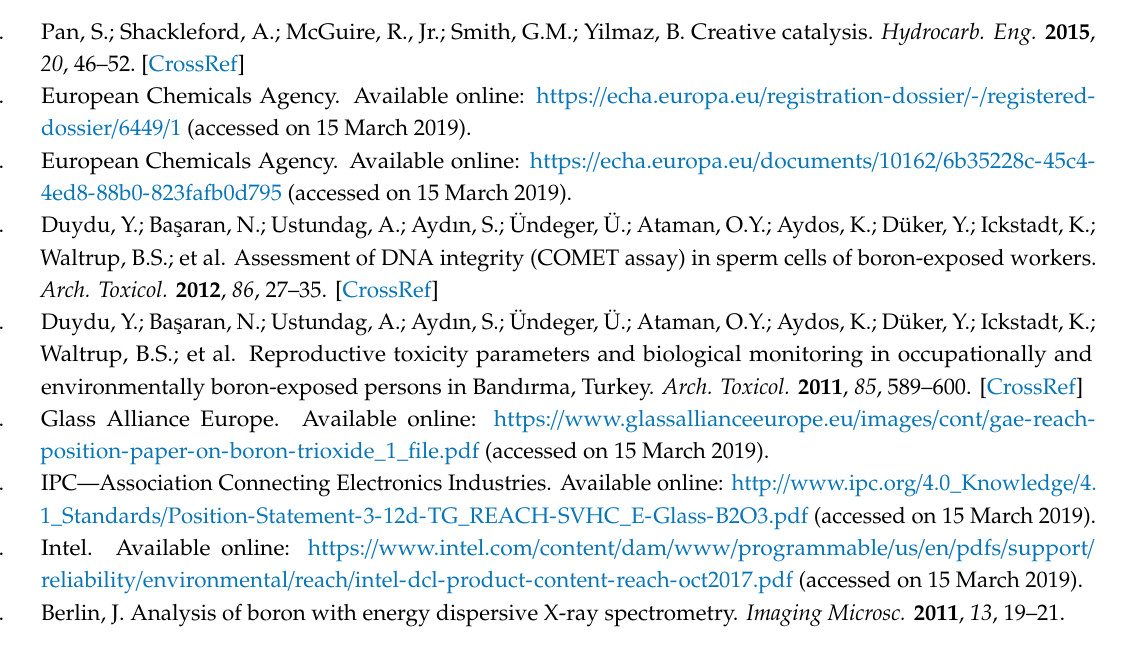
Figure S1: XPS P 2s and B 1s spectra for FCC ZSM-5 additive samples without boron (top) vs. with 1 wt.% B 2 O 3 (bottom). B 1s region is overlapping with P 2s region, Figure S2: 11 B NMR spectrum of ZSM-5 additive with 1 wt.% B 2 O 3 , Figure S3: 11 B NMR spectra for (a) Al-borate and (b) B-phosphate (c) Boron